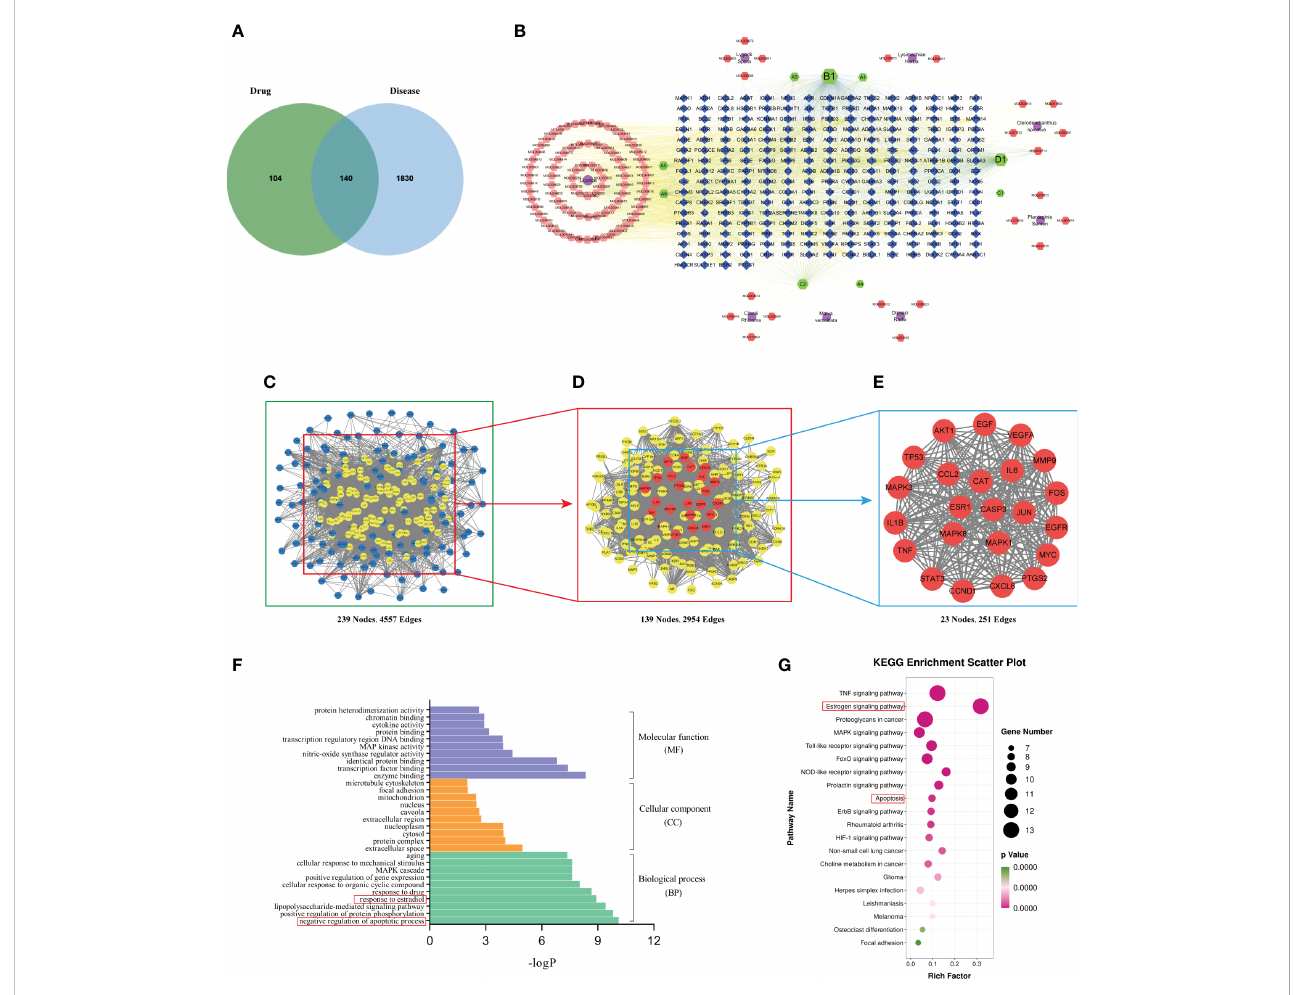
FIGURE 2 Network pharmacology analysis. (A) Target intersections between BSHS and KS. (B) The network of drug-compound-target included 8 kinds of herbs, 126 active components, and 244 target genes. Purple circle: drug, orange and green hexagon: active ingredients of BSHS; blue quadrilateral: targets. (C) A PPI network of predicted BSHS targets against KS. (D) A list of signi fi cant proteins from the PPI network was derived from (C) . (E) A list of 23 key proteins of BSHS in KS treatment was derived from (D) . (F) Based on the GO enrichment analysis, these are the top 10 indicators of BP, CC, and MF. (G) The top 20 signaling pathways were identi fi ed according to